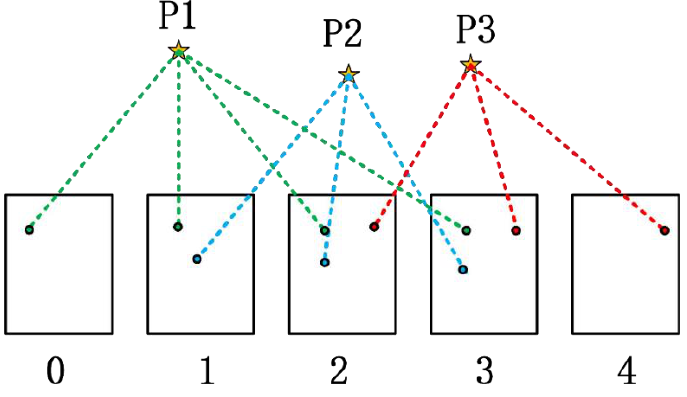
Figure 6. Feature point management method.